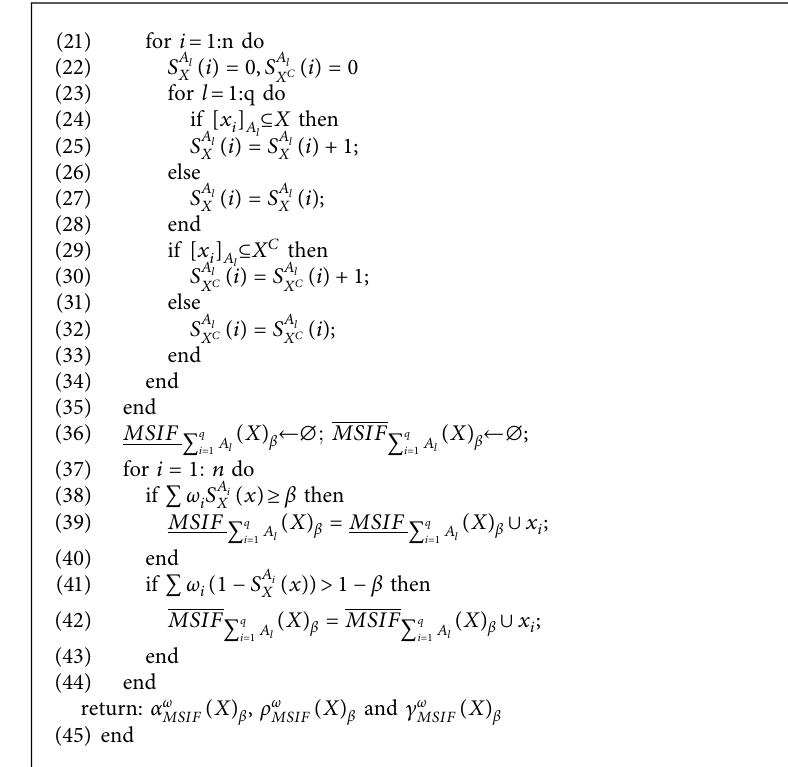
A LGORITHM 2: Uncertainty measurement of weighted generalized multigranulation intuitionistic fuzzy rough sets for